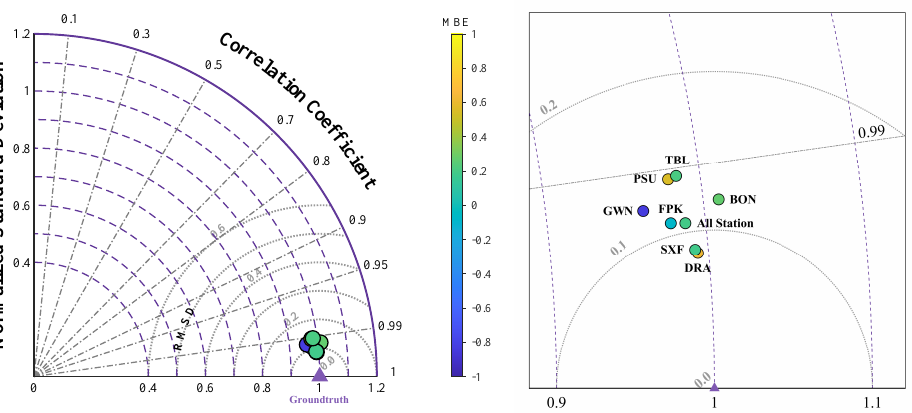
Figure 9. Taylor Diagrams for evaluating DRFCN+RF on SURFRAD test data. The point labeled groundtruth represents the reference value. The color of each circle represents the nMBE ( % ) .